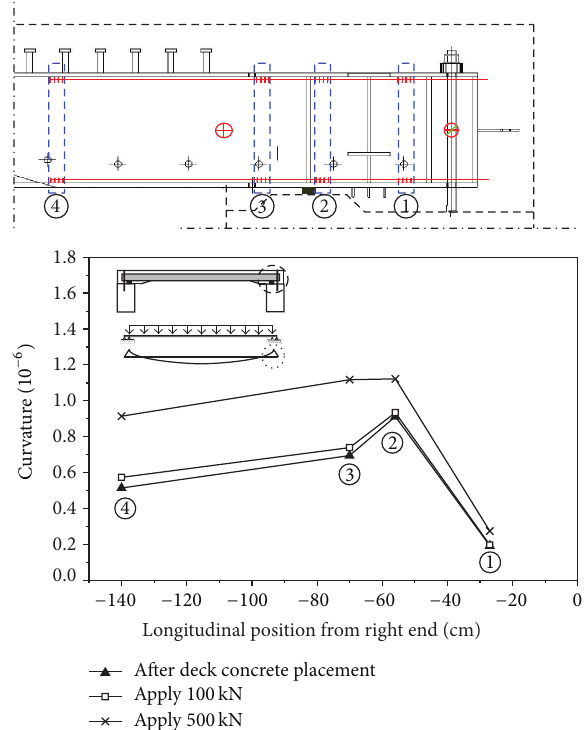
Figure 8: Curvature distribution after concrete placement and in service.